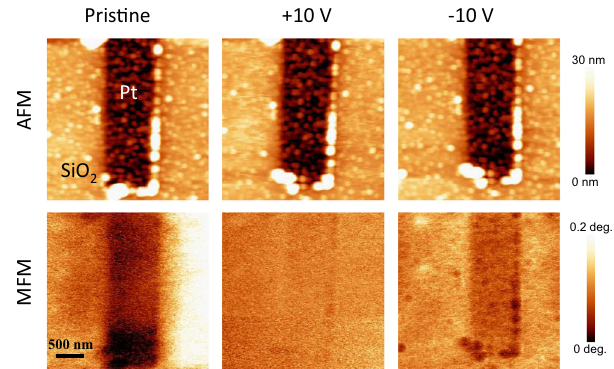
Fig. 4 Topographic and magnetic surface characterization in response to applied voltages. Top row: topographic images of a segment of the Pt Hall cross before and after application of the poling pulses (2 s; ±10 V). Bottom row: MFM images of the same segment after application of the poling pulses.